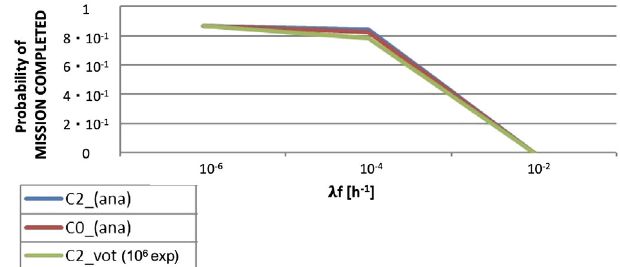
FIG. 16. Probability of mission completed against λ f (explicit simulation with 10 6 cycles for varied parameters in C2_vot).